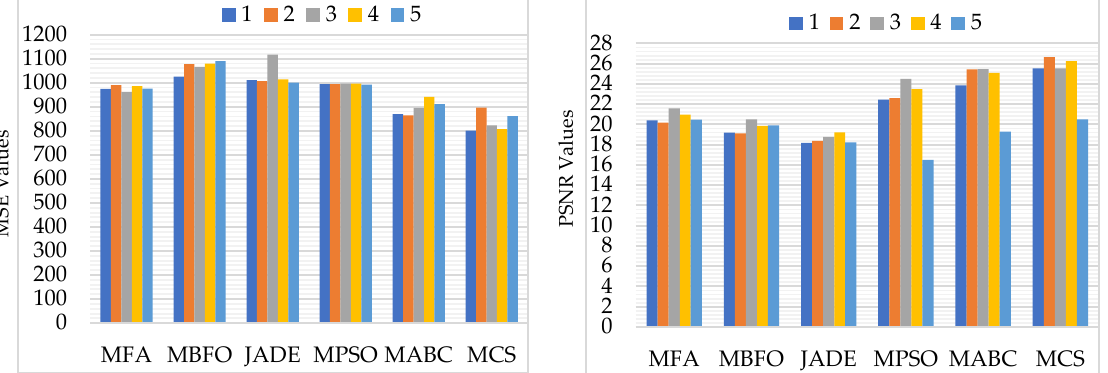
Figure 10. CPU time using different optimization algorithms with GLCM. Table 7. CPU time using different optimization algorithms with GLCM and Rényi’s entropy method.